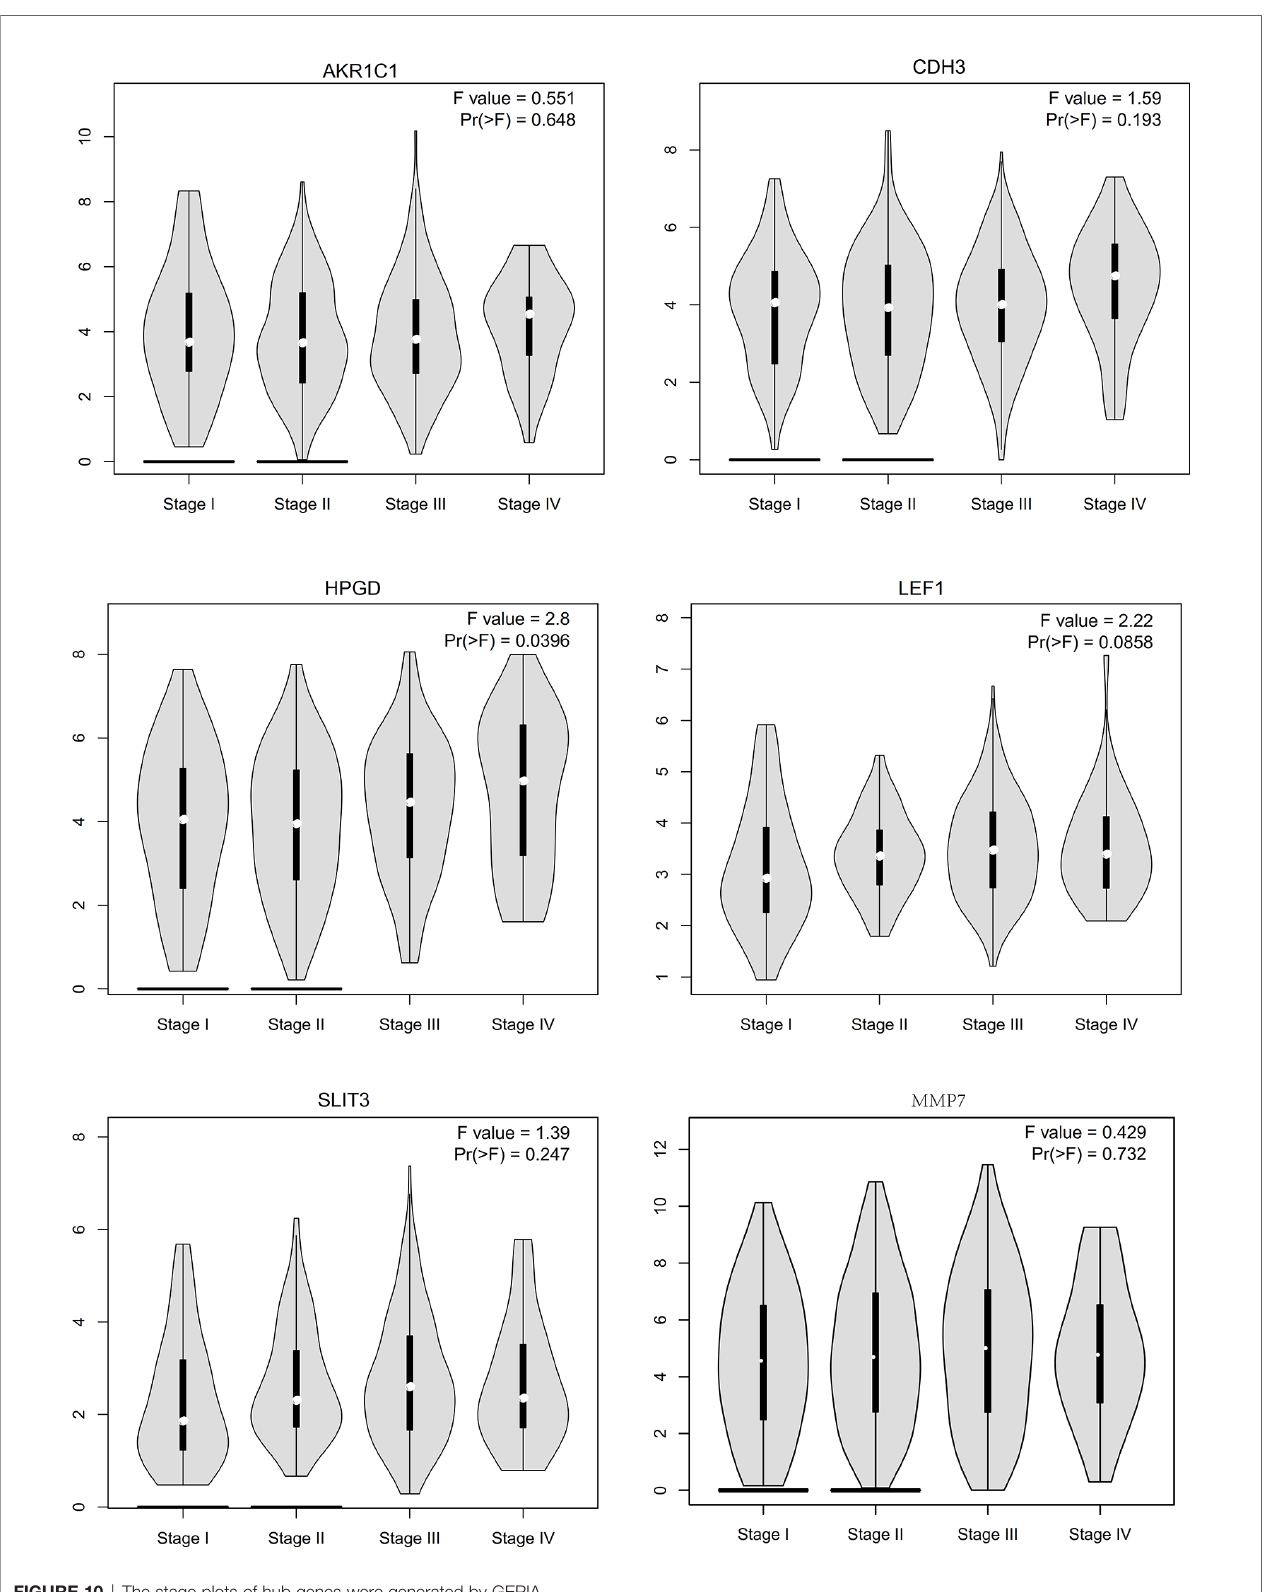
FIGURE 10 | The stage plots of hub genes were generated by